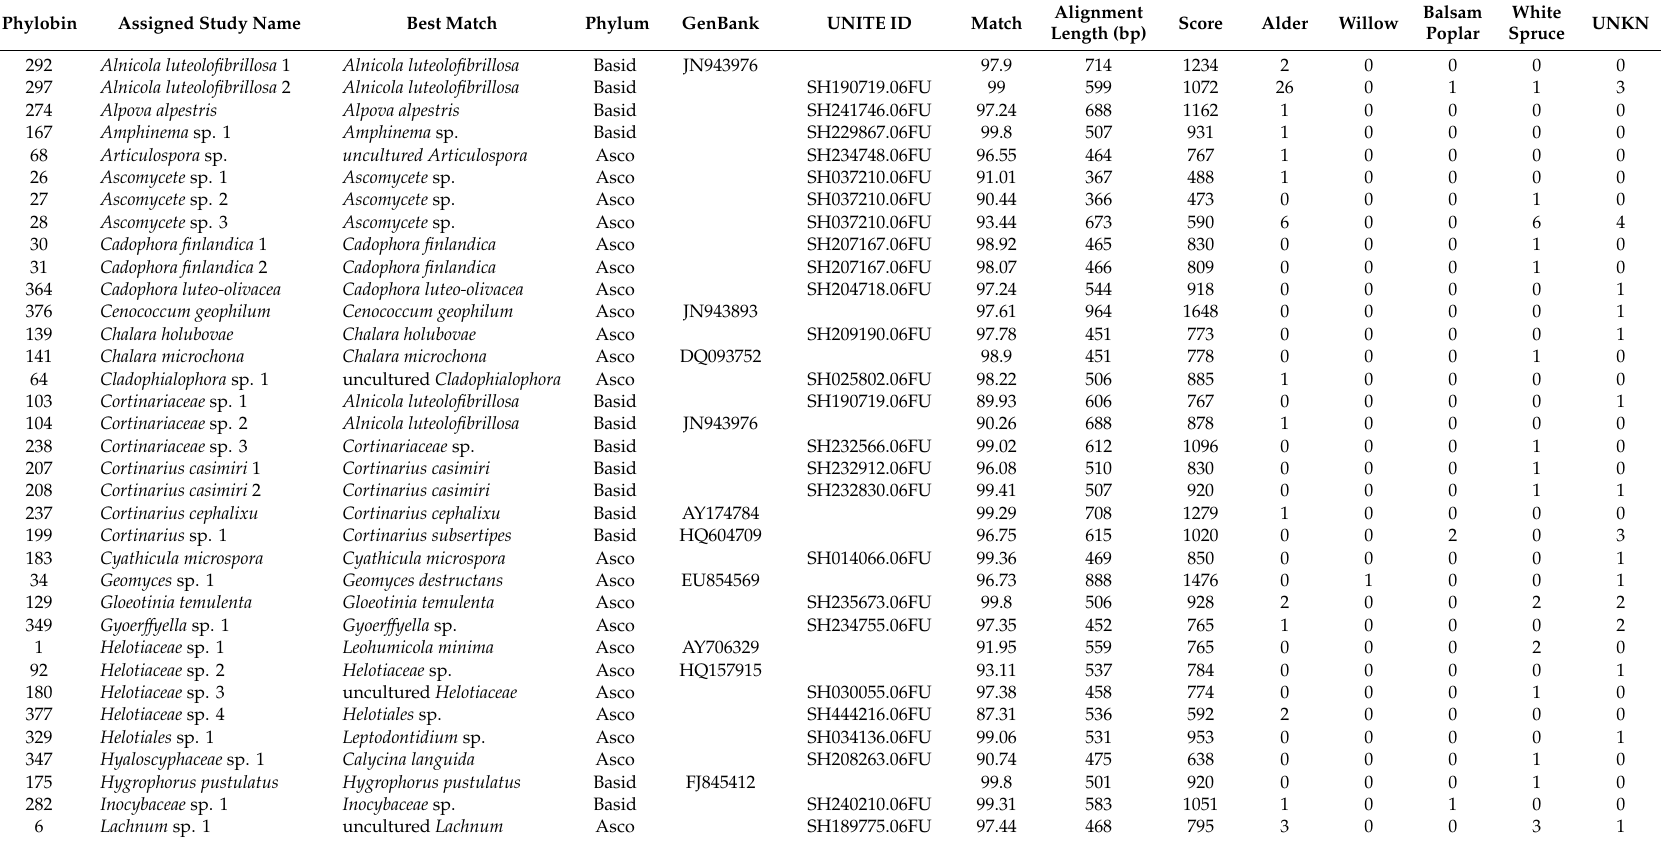
Table A1. Ectomycorrhizal fungi associated with Alder, Willow, Balsam poplar, White spruce, and unknown host (UNKN) sampled across early, mid and late successional stands along the Tanana River floodplain, Alaska. Tips with unknown hosts were not included in the analyses presented in this manuscript, but are included in this table as a record of what EMF species were recorded at these